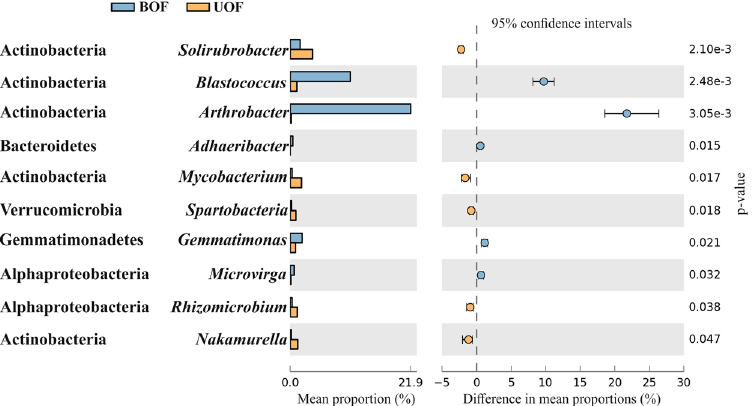
Figure 2. Genera that exhibited significant and biologically relevant changes in abundance. Significant differences were calculated using White’s non-parametric t-test at a 95% confidence interval. Biologic relevance was determined choosing genera with a difference between proportions > 0.5 and a ratio of proportions >